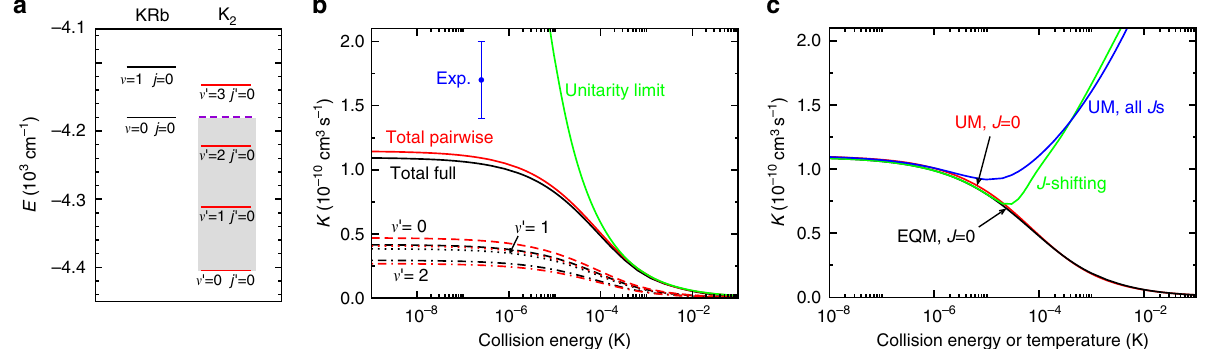
Figure 2 | Energetics and reaction rates. ( a ) Energetics of the KRb þ K - K 2 þ Rb reaction. The j ¼ 0 vibrational levels of the KRb X 1 S þ potential and j 0 ¼ 0 potential are shown by black and red lines, respectively. The grey shaded area indicates the closely spaced energetically vibrational levels of the K 2 X 1 (cid:2) þ g allowed rotational levels of K 2 . The zero of energy is located at the dissociation limit of KRb and K 2 . ( b ) Reaction rate coefficients from J ¼ 0 EQM calculations based on either the full (black curves) or pairwise (red curves) potential as a function of collision energy in units of the Boltzmann constant. The total and vibrationally resolved reaction rate coefficients are shown. The green curve is the s -wave unitary rate coefficient for atom-dimer scattering. The closed circle with error bars (one s.d.) corresponds to an experimental measurement 1 taken at a temperature of 250nK. ( c ) Total reaction rate coefficient (green curve) as a function of temperature based on the J -shifting method and the J ¼ 0 EQM results for the full trimer potential. The black curve repeats this latter curve from ( b ) as a function of energy. The red curve shows the rate coefficient of the s -wave universal model (UM) as a function of collision energy, while the blue curve shows the UM data including all relevant partial waves as a function of